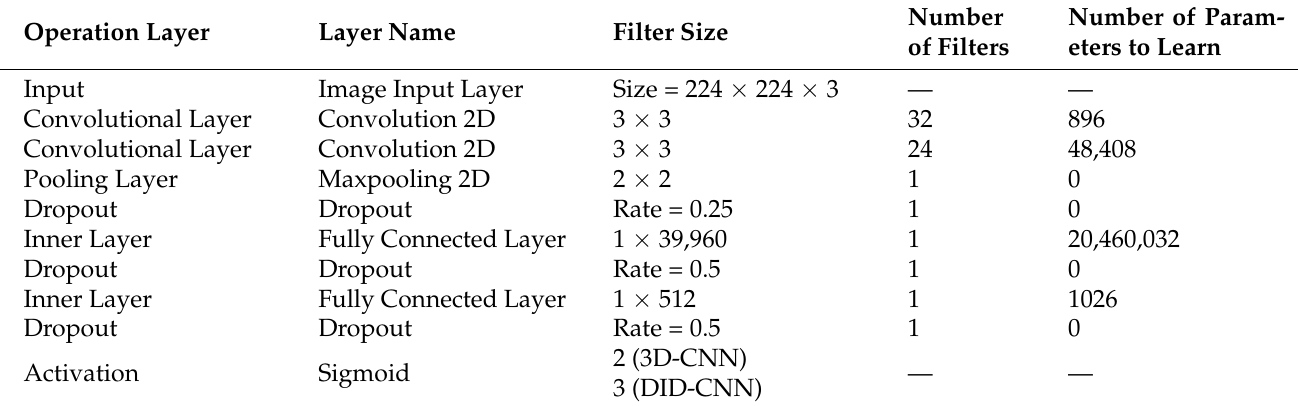
Table 2. The proposed networks for defect detection (3D-CNN) and diameter classification (DID-CNN).